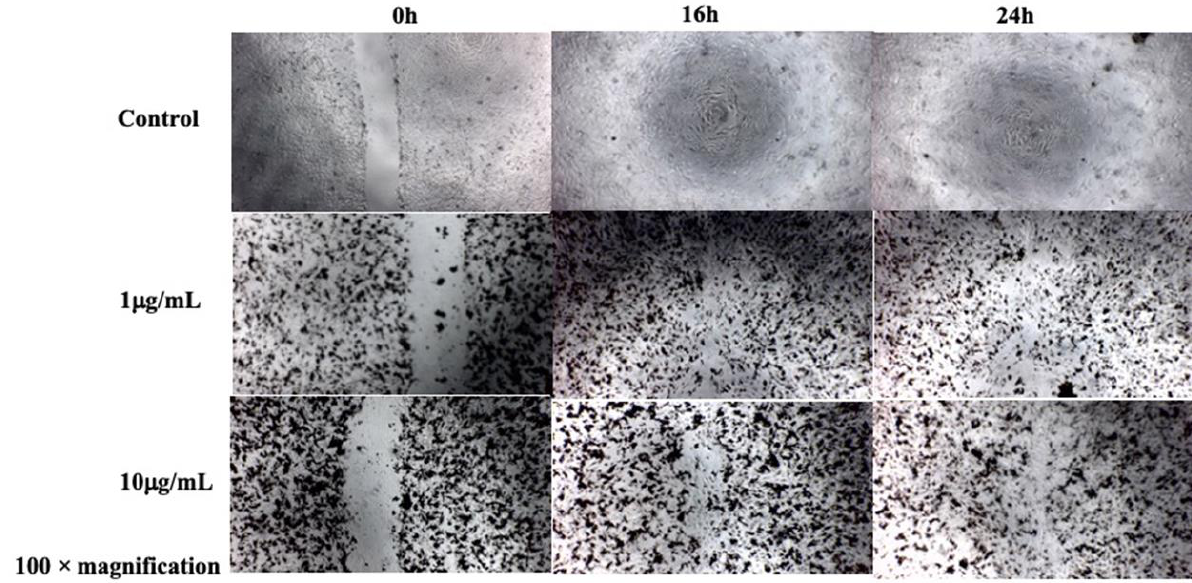
Figure 5. Migration assay of BCECs treated under varying concentrations of D-SPIONs over 16 and 24 h.